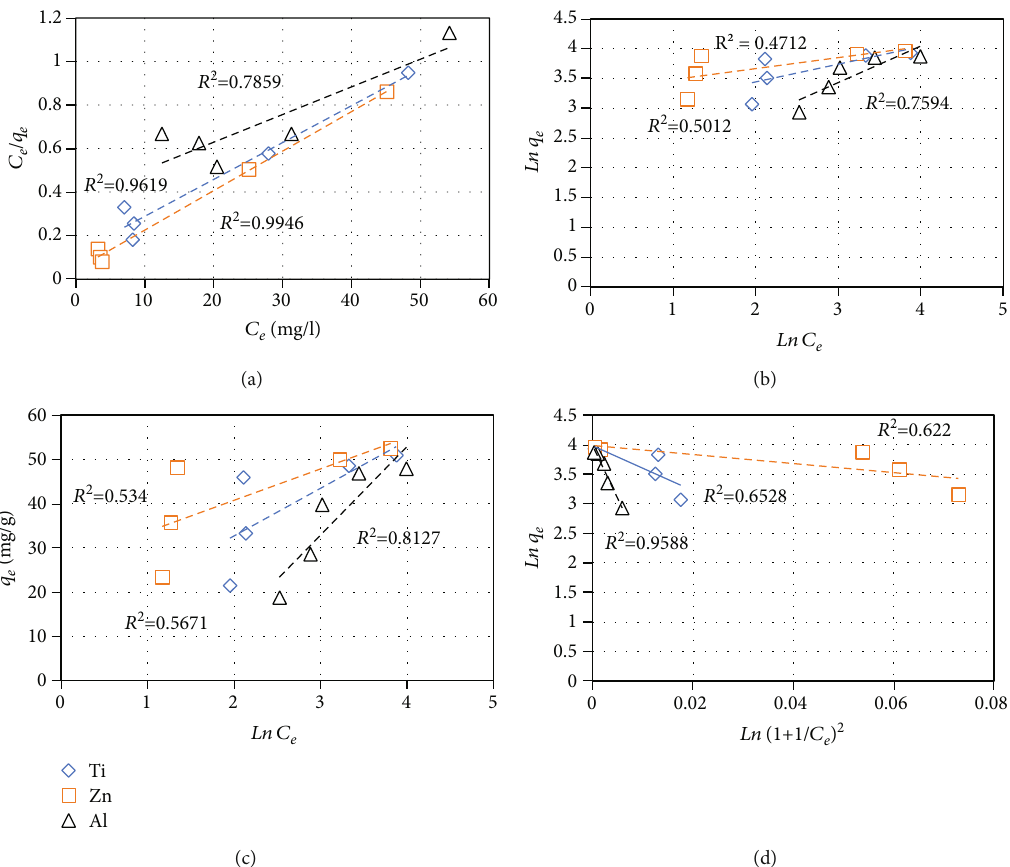
Figure 6: Equilibrium isotherms of Pb(II) onto all adsorbents: (a) Langmuir, (b) Freundlich, (c) Temkin, and (d)